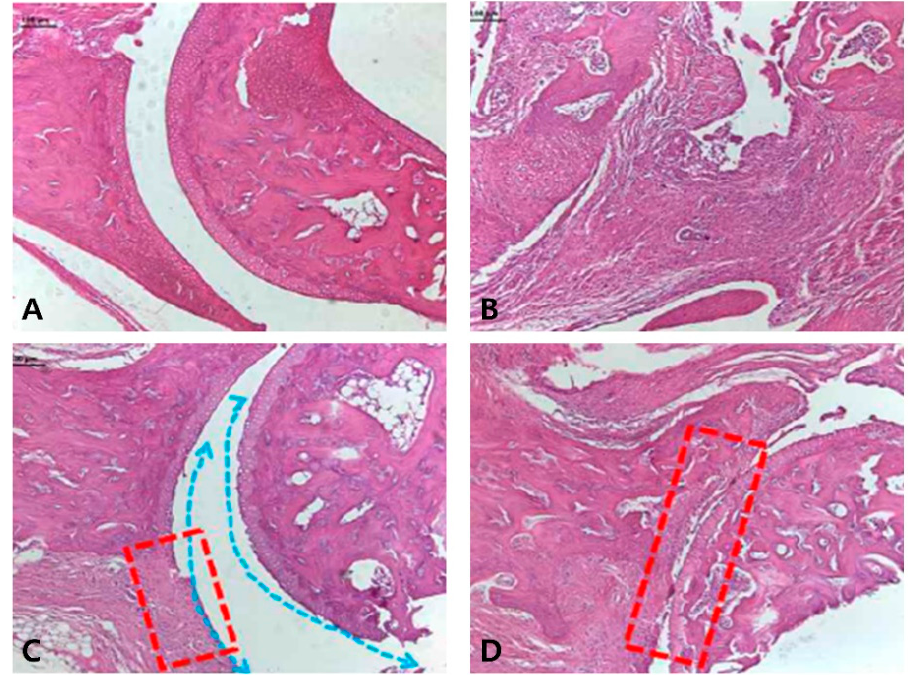
Figure 6. Histological analysis of knee joint. ( A ) Normal control; ( B ) CIA group; ( C ) 200 mg/kg of S. muticum extract; ( D ) positive control (Joins, 10 mg/kg). Irregularity of the cartilage surface (blue arrow) was found in (C) and damages to the cartilage (the replacement of fibrotic tissue, red box) were found in (C) and (D). Images are magnified × 100.